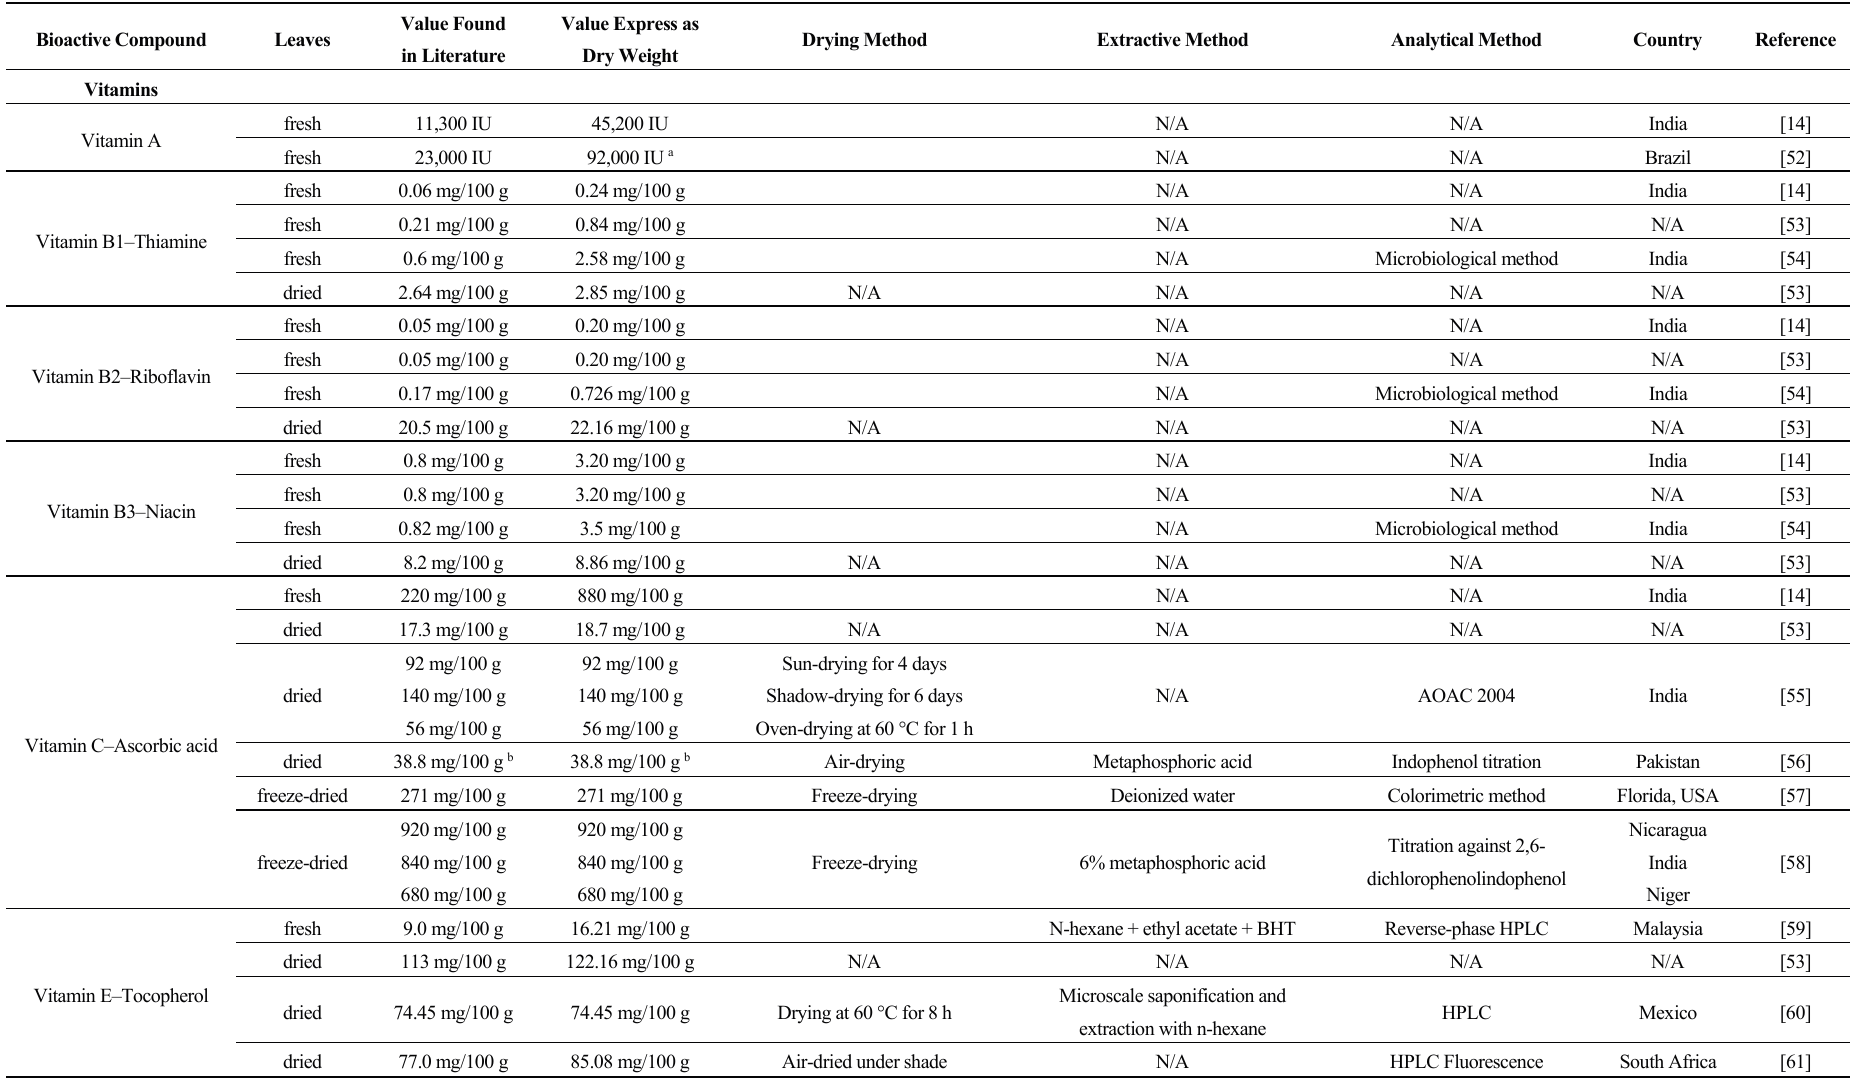
Table 1. Vitamins content in Moringa oleifera